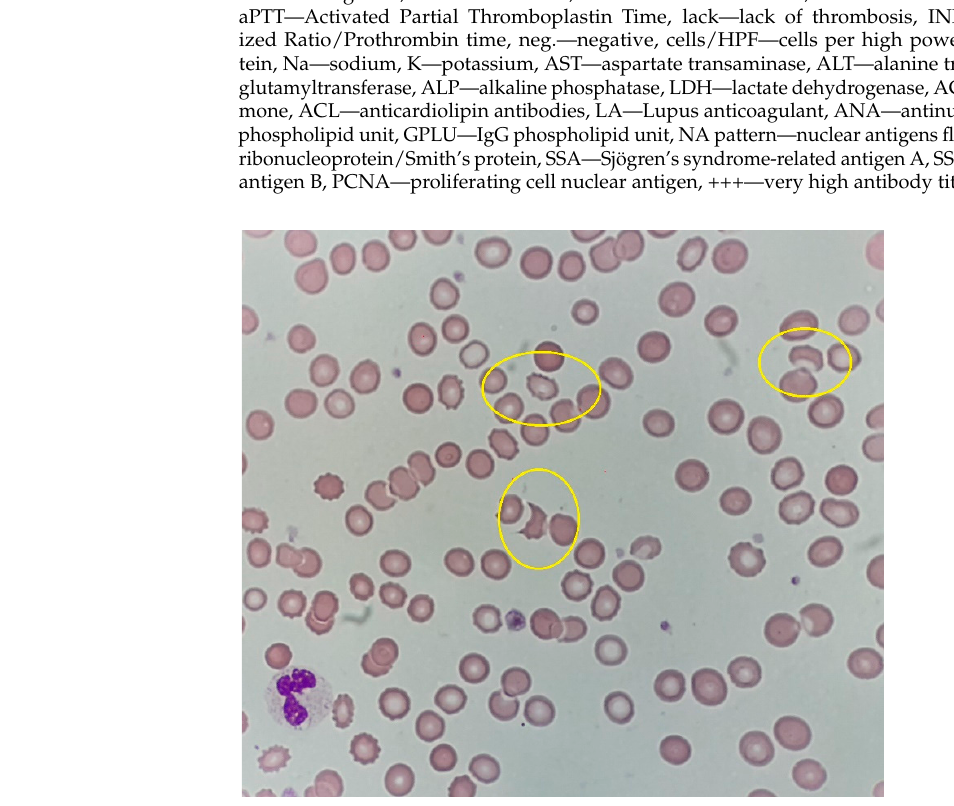
Figure 1. Schistocytes in peripheral blood smear (H&E, 1000×). Bacteriological and fungal cultures of urine and blood were negative. Microbiological profile of leg ulcer showed only slight (+) Staphylococcus aureus and sparse Klebsiella pneumonia (sensitive to most antibiotics) colonization. Chest X-ray showed no abnormalities. Ultrasound and computed tomography of the abdominal cavity showed a dilated venous vessel in the peritoneal cavity (without signs of portal thrombosis in Color Doppler), retroperitoneal lymphadenopathy (up to 12 mm in diameter) and a normal biliary tract; the liver, spleen, pancreas, kidneys and adrenal glands were of the correct shape and size under homogeneous contrast enhancement. In-hospital therapy, including intravenous (i.v.) hydrocortisone 200 mg/d, subcutaneous (s.c.) dalteparin 5000 IU/d and i.v. ciprofloxacin 400 mg/d resulted in immediate relief of abdominal pain and fatigue. Unfortunately, during the next 3 days of hospitalization, platelet count decreased to 20 × 10 9 /L (reference range: 130–400 × 10 9 /L). Therefore,